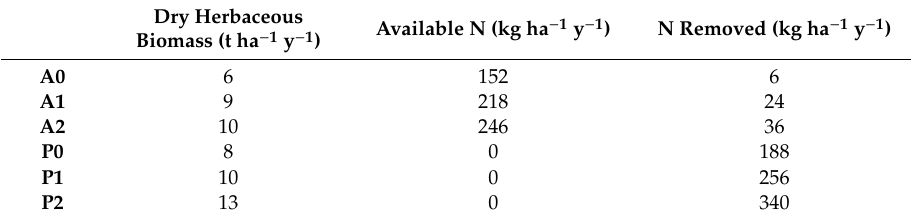
Table 5. N amount in herbaceous